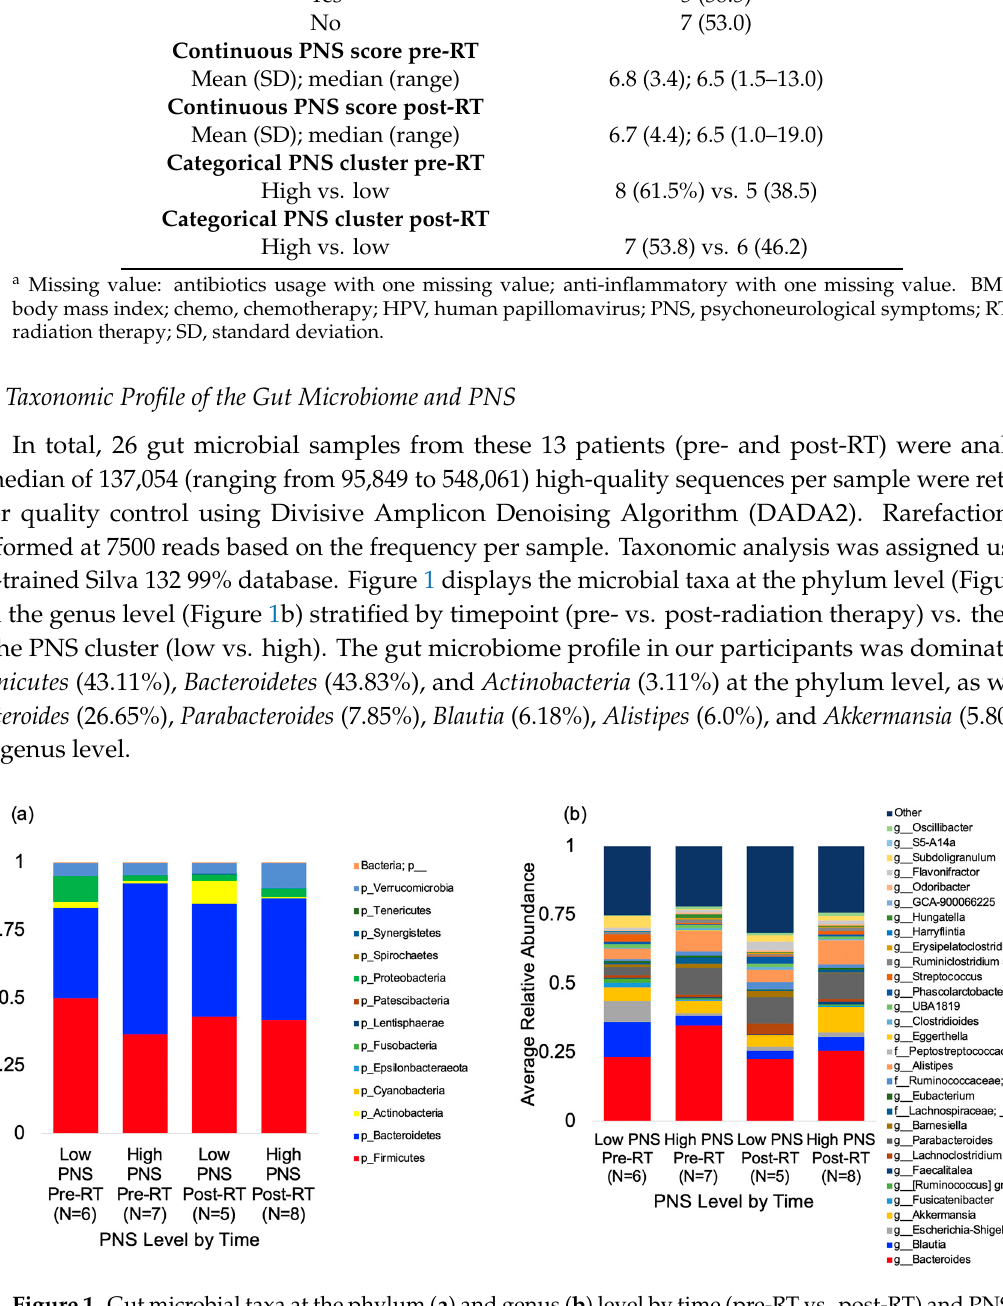
Figure 1. Gut microbial taxa at the phylum ( a ) and genus ( b ) level by time (pre-RT vs. post-RT) and PNS levels (low vs. high). All the microbial phyla and top 20 genera are displayed. PNS, psychoneurological symptoms; RT, radiation therapy.